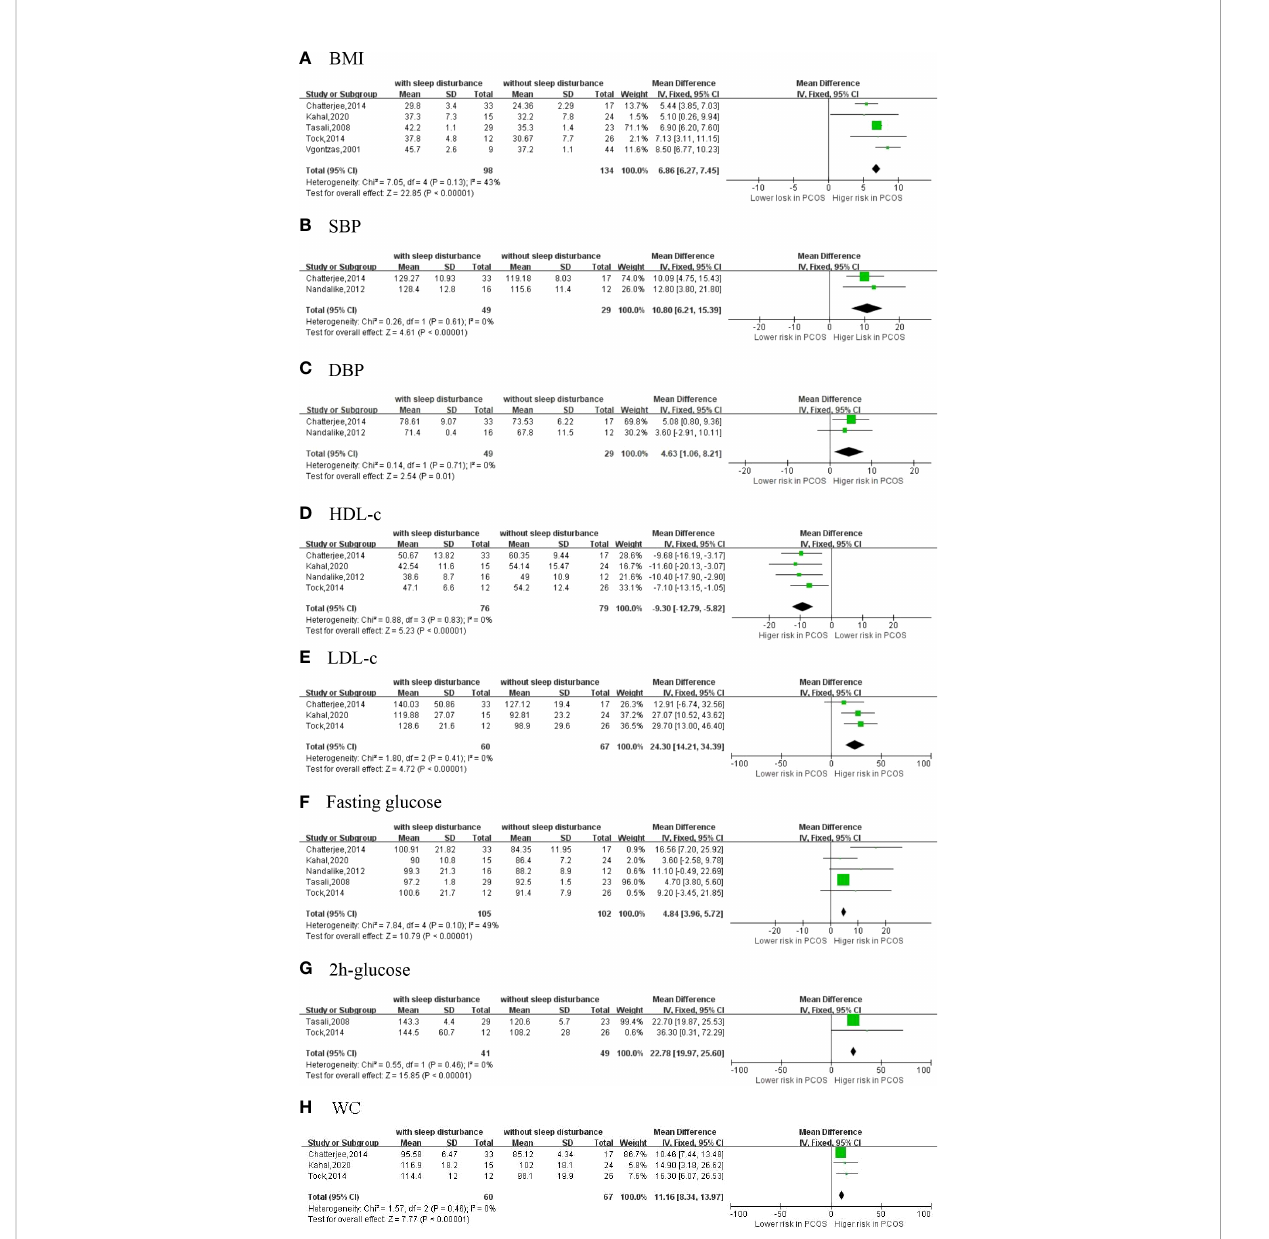
FIGURE 4 The secondary outcomes [ (A) BMI; (B) SBP; (C) DBP; (D) HDL-c; (E) LDL-c; (F) Fasting glucose; (G) 2h-glucose; (H)